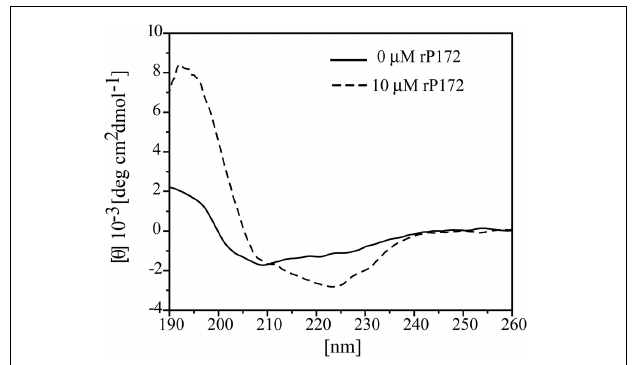
FIGURE 8 | Structural changes of ameloblastin (Ambn) in the presence of amelogenin (Amgn) provide evidence for their co-assembly. Far-UV circular dichroism (CD) spectra of 10 μ M rMAmbn only (solid line) and in the presence of 10 μ M rP172 (dashed